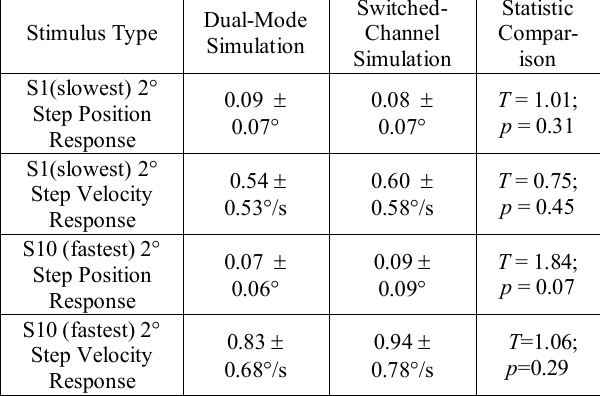
Table 4: Average Error with one standard deviation for the entire response for the Dual-mode and Switched-channel simulations for 2  responses after the Switched-Channel model was adjusted. A student t-test was used for